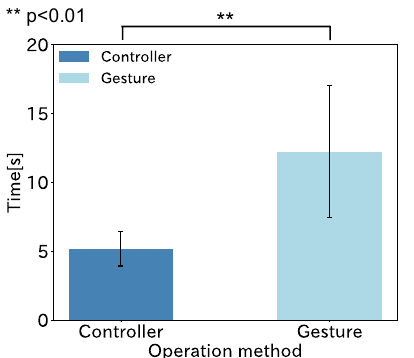
Figure 17. Task completion results summarized for all